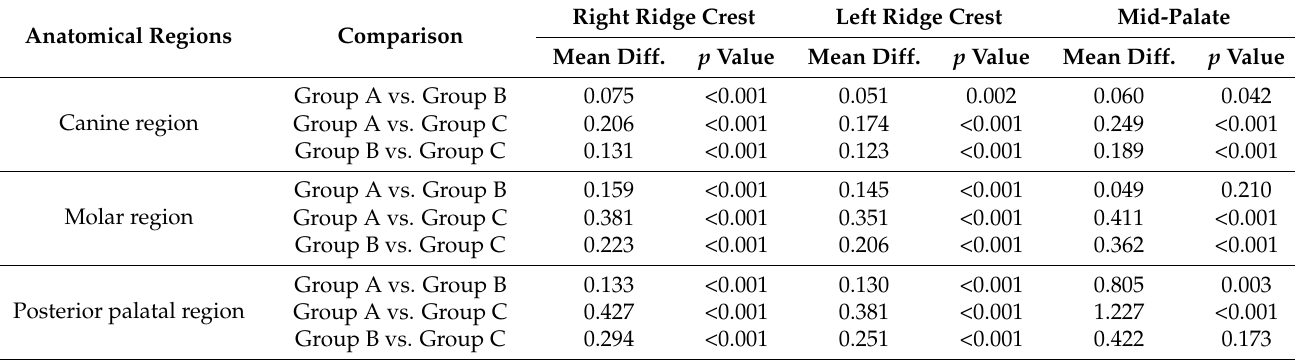
Table 2. For each site of the canine region, comparisons of difference in mean dimensional discrepancy (mm) between groups by Tukey test at 24